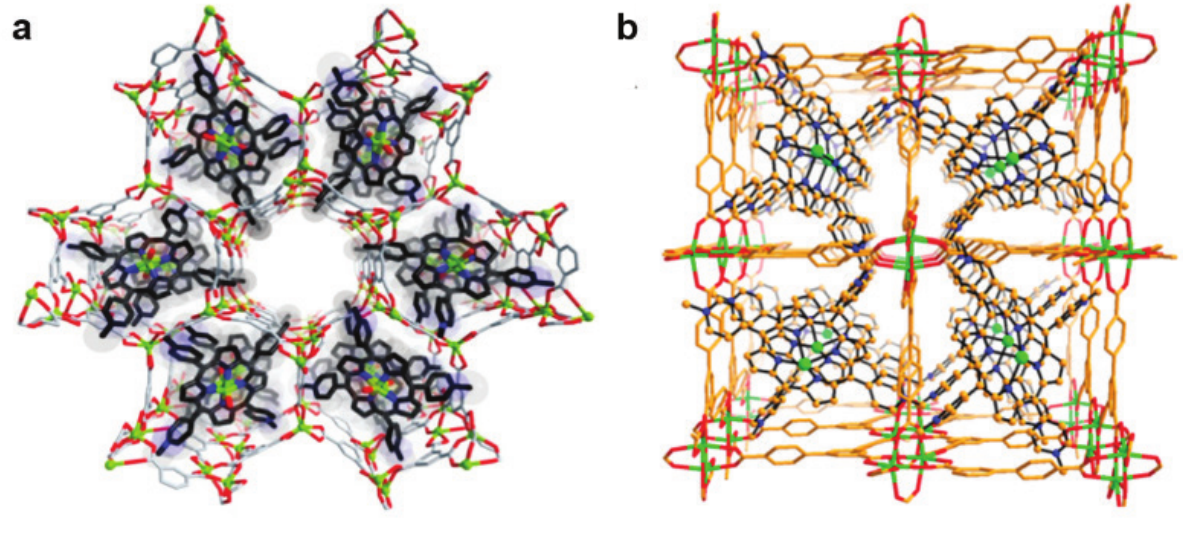
Figure 13: (a) Porph@MOF-12 showing the mzz topology and hexagonal channels; (b) Porph@MOF-13 viewed along the a-axis showing the square channels as well as MnTMPyP encapsulated in all channels [114]. Reprinted with permission from Ref. [114]. Copyright © 2014, American Chemical Society.